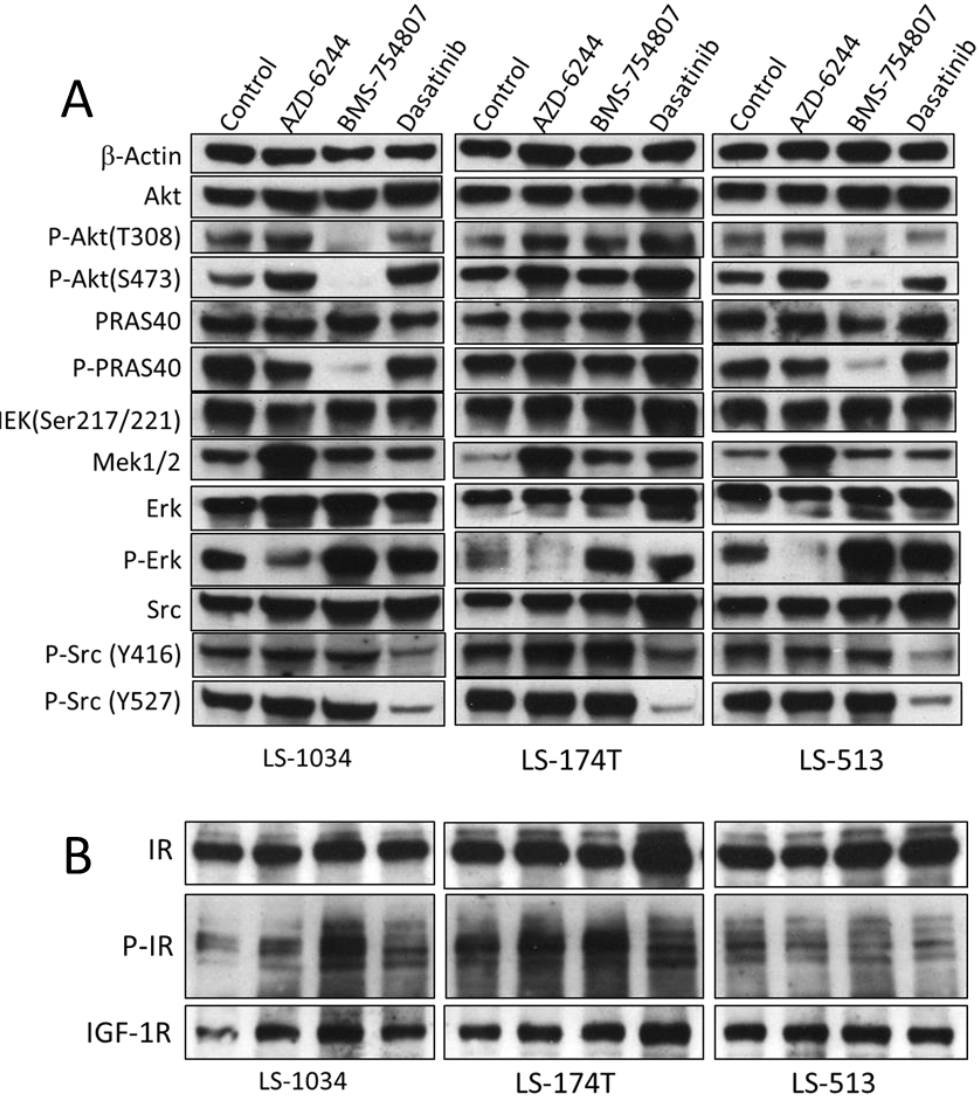
Figure 3. Western blot analysis of the effect of AZD-6244, BMS-754807 and dasatinib on the signaling pathways of selected CRC cell lines. LS-1034, LS-174T, and LS-513 were cultured to 70% confluency, and they were then treated by 5 µ M AZD-6244, 2 µ M BMS-754807 or 1 µ M dasatinib for 1 h. Cells treated with culture medium containing no drug under identical conditions were used as controls.